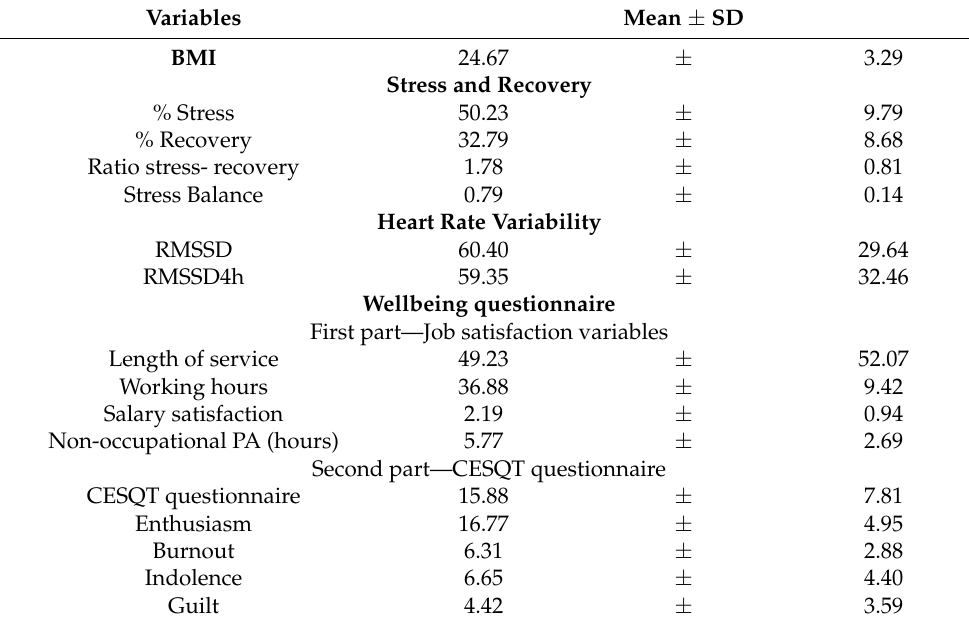
Table 3. Outcomes form the studied